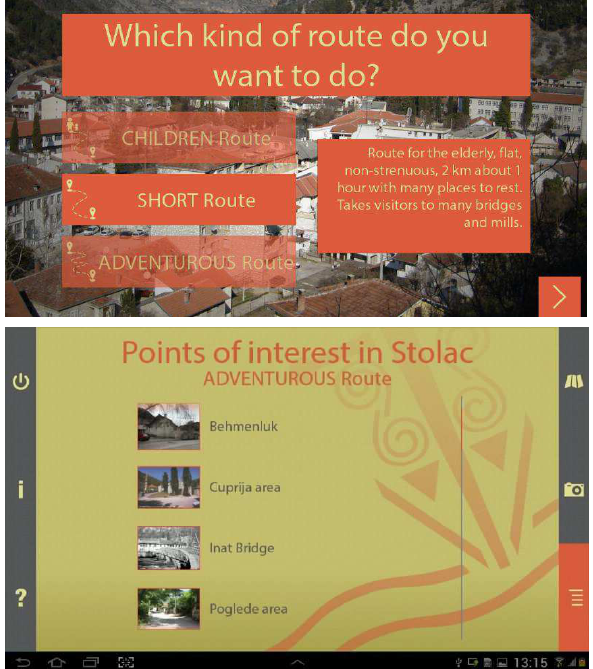
Figure 7 a screen capture images of the smartphone